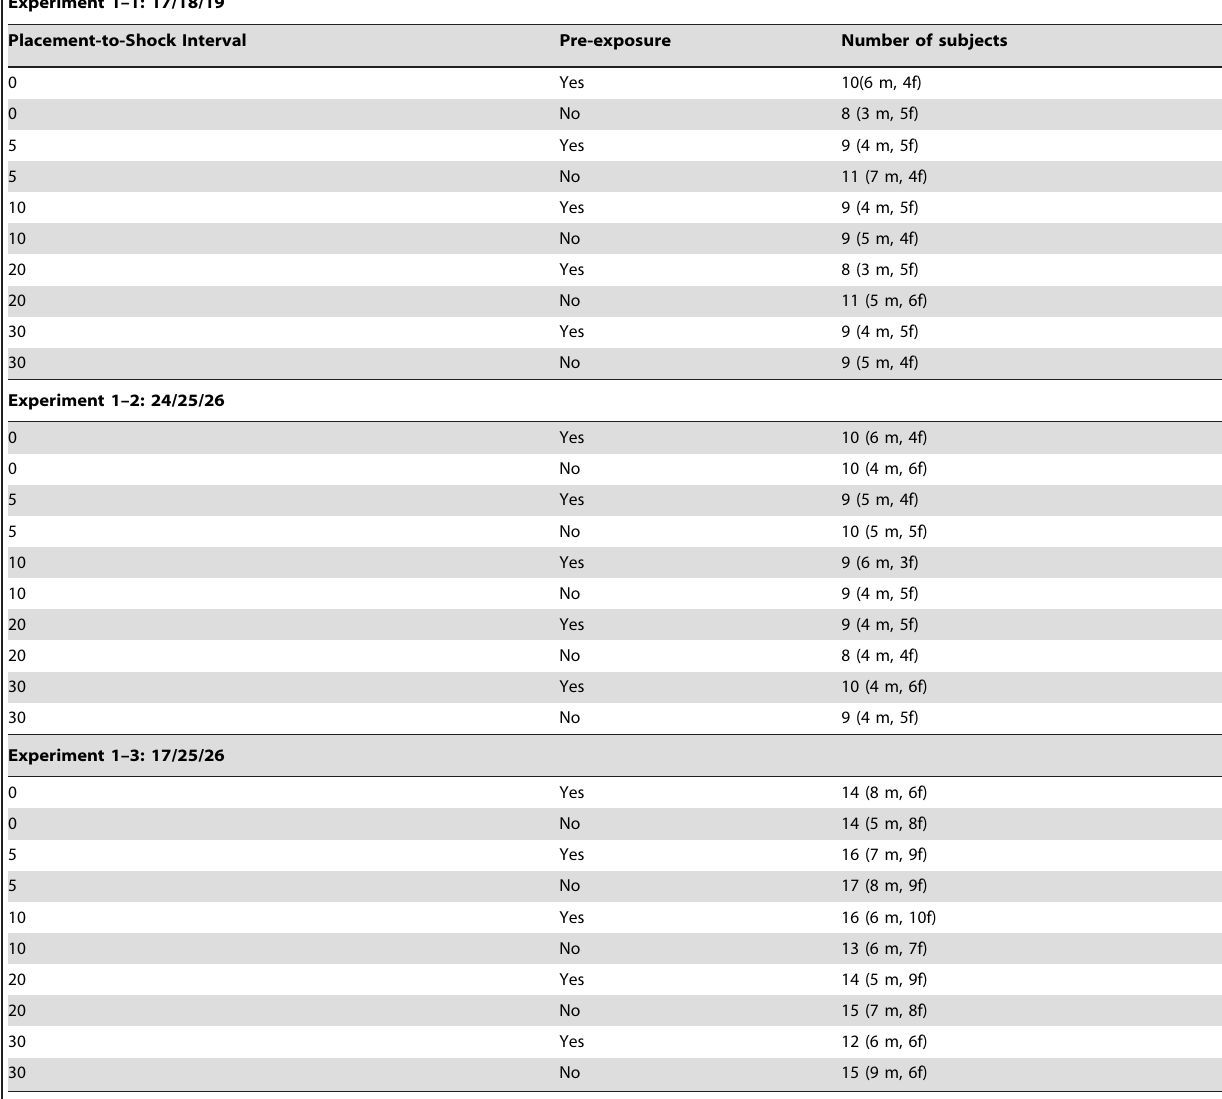
Table 1. Experimental groups and design for Experiment 1.